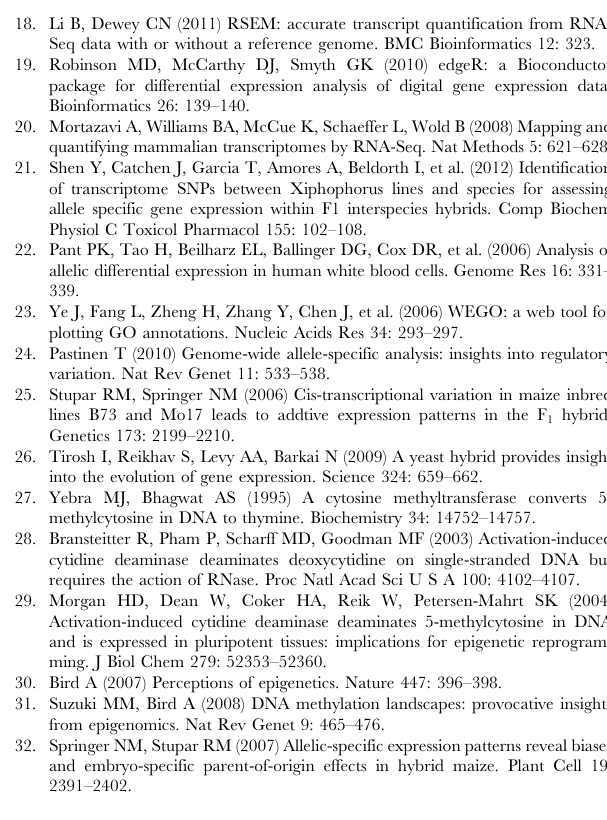
Table S1 SNPs detected in the hybrid at tillering and heading stages.